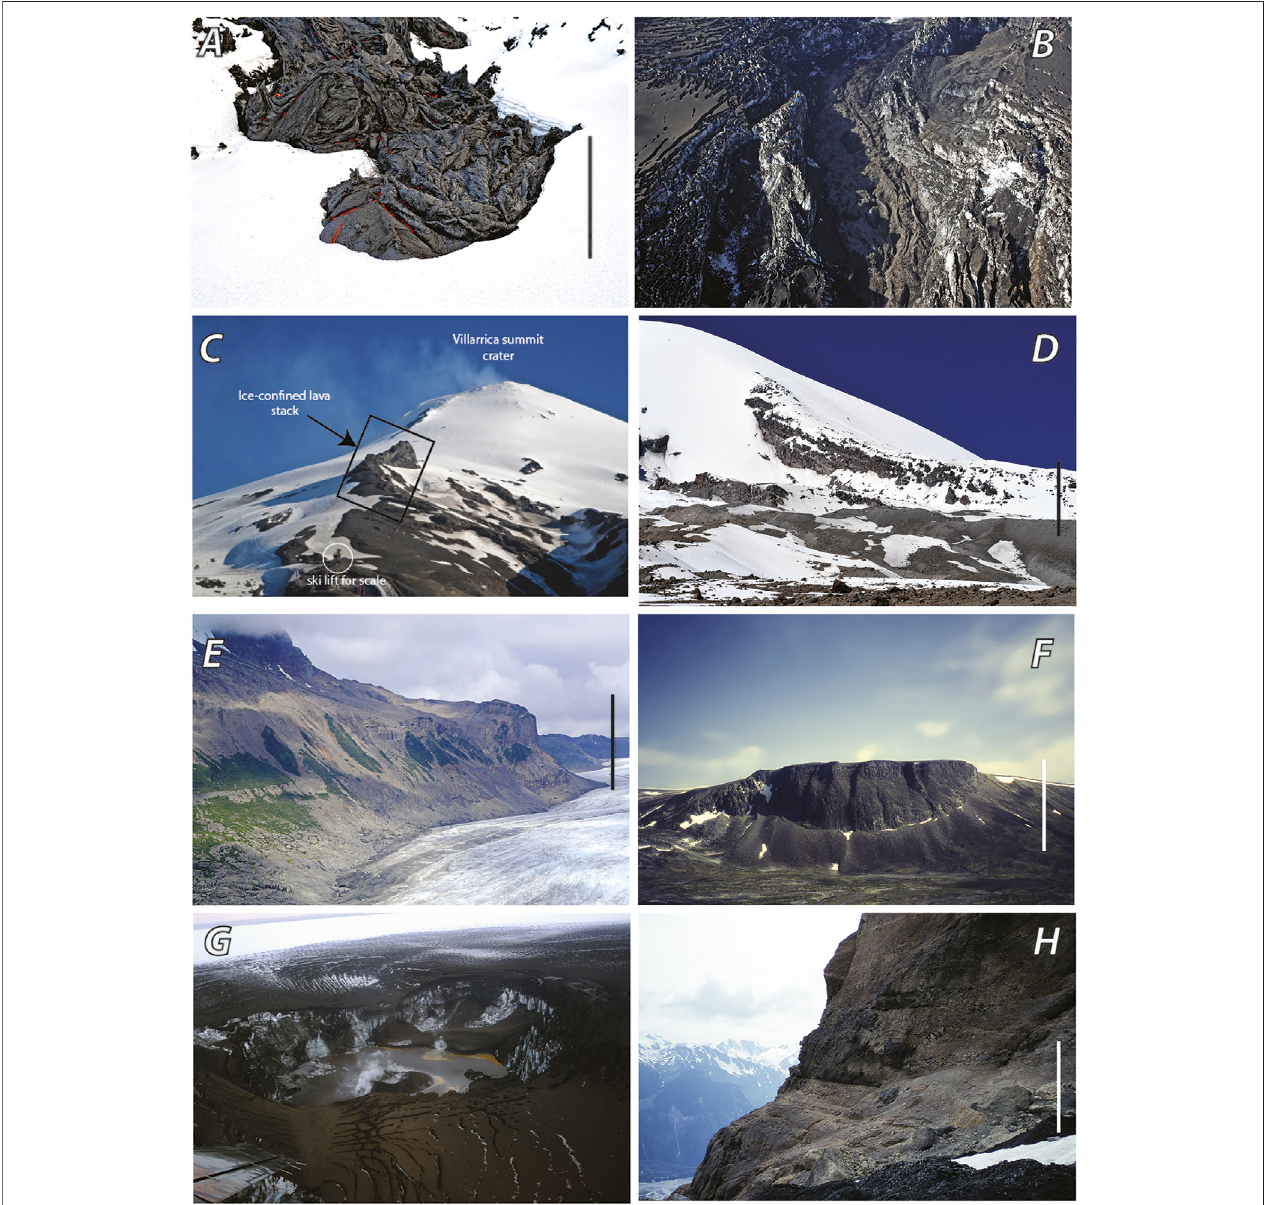
FIGURE 6 | Glaciovolcanic deposits whose structure and character are indicative of emplacement in a cryospheric environment. (A) Lava fl ow emplaced onto of snowpack, which subsequently melted through the snow, Tolbachik, Russia. (B) Lava con fi ned within a canyon of ice, Gigjökull, Iceland. (C) Stacked lava ridge on the northsummit ofVillarricavolcano,Chile. (D) Stackedlavaridgeonthewesternsummitdome, Coropunavolcano,Peru. (E) Ice-boundedlavaonthenortheasternsideof HoodooMountainvolcano,BritishColumbia,Canada. (F) IcedammedlavaatLlangorseMountain,northernBritishColumbia,Canada. (G) Eruptionsitefrom2004 Grimsvötn,Iceland,showingtephracoveredglacier,englaciallake,andnewlyproducedtephracone. (H) Horizontally-beddedvolcaniclasticdepositsat1500ma.s.l.on the southern fl ank of Hoodoo Mountain volcano, British Columbia, Canada.